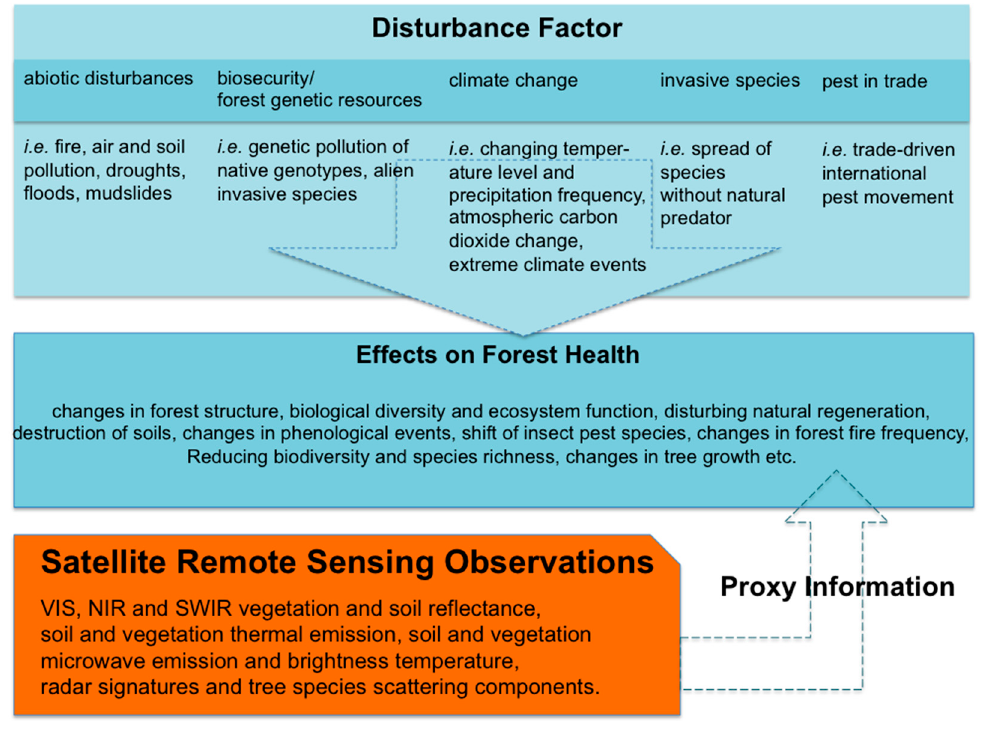
Figure 1. General impacts on forests, their origins and their effects on forest health together with remote sensing observations for identifying proxy information for factors relevant to forest health. The disturbance groups and factors are modified after FAO (Food and Agriculture Organization of the United Nations).